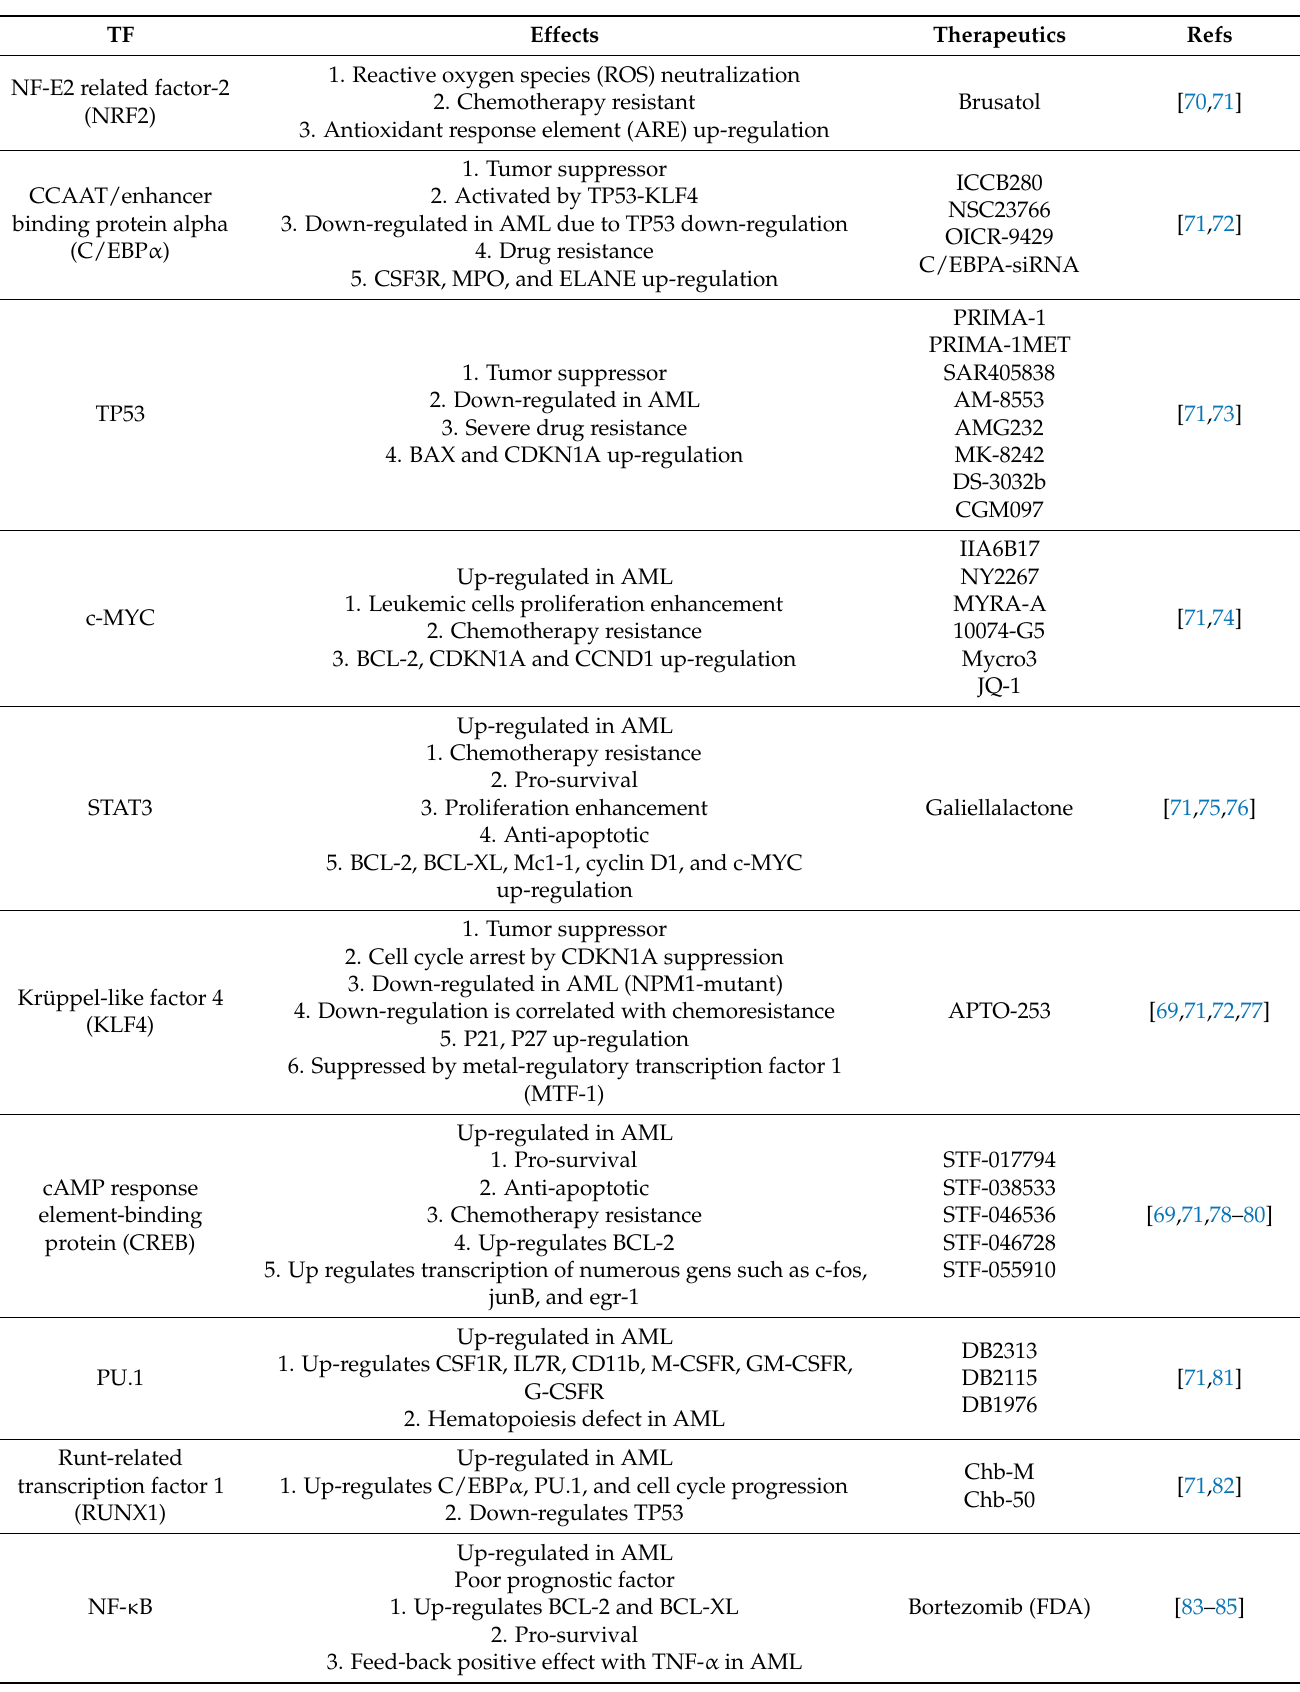
Table 3. Transcription factor roles in